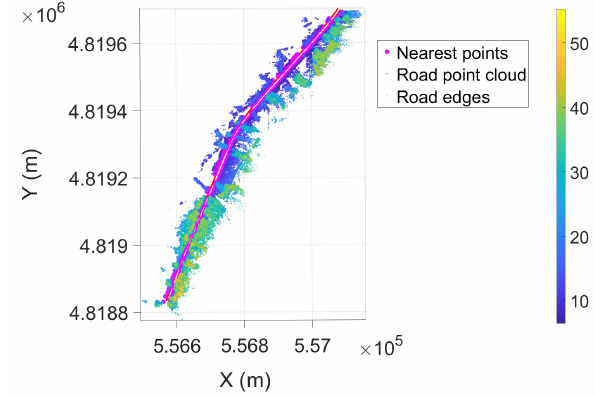
Figure 12. Vegetation detected with more than 5 m of height.